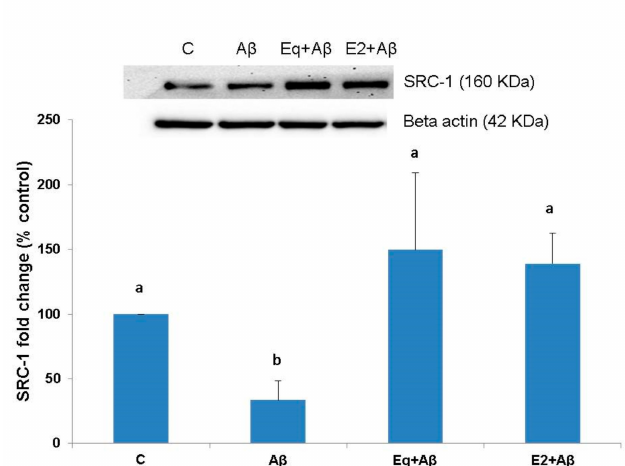
Figure 3. The SRC-1 expressions of SH-SH5Y cells from di ff erent treatments. Protein expressions were assessed by Western blotting. Data were analyzed by a one-way ANOVA followed by the LSD post-hoc test and are representative of three independent experiments ( n = 3). Values are presented as the mean + SD. Bars with di ff erent letters are significantly di ff erent at p < 0.05.